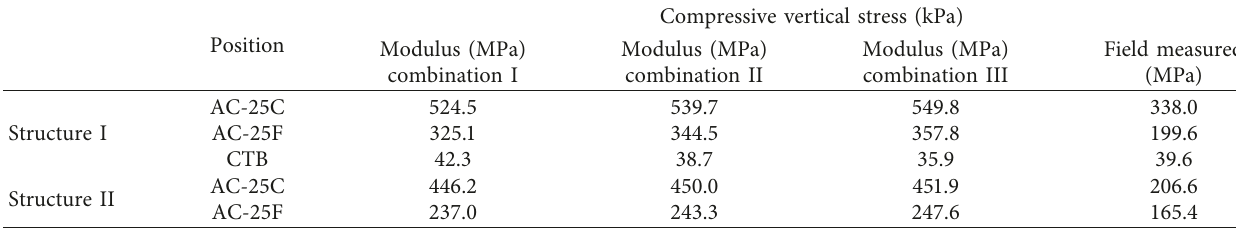
Figure 13: Comparison of theoretical horizontal tensile strain and measured tensile strain. (a) Structure I. (b) Structure II. Table 4: Compressive vertical stress.